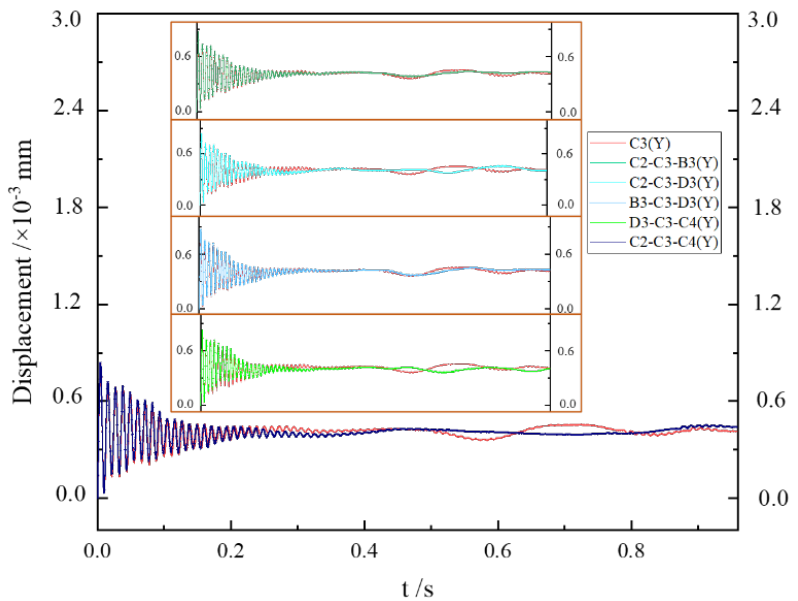
Figure 17. Axial displacement comparison of three vibrating helical tubes.